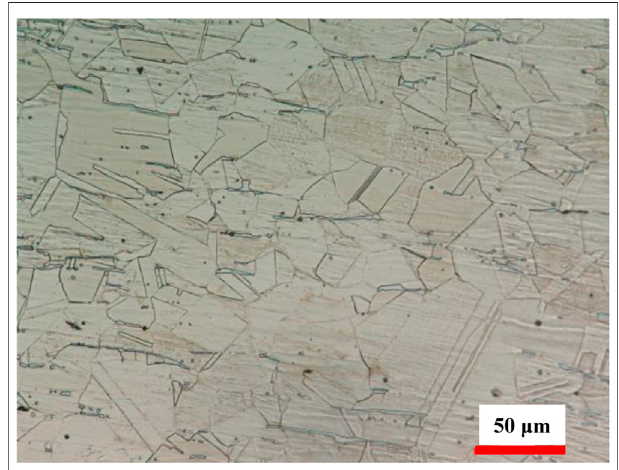
FIGURE 1 | Optical microstructure of the base metal.